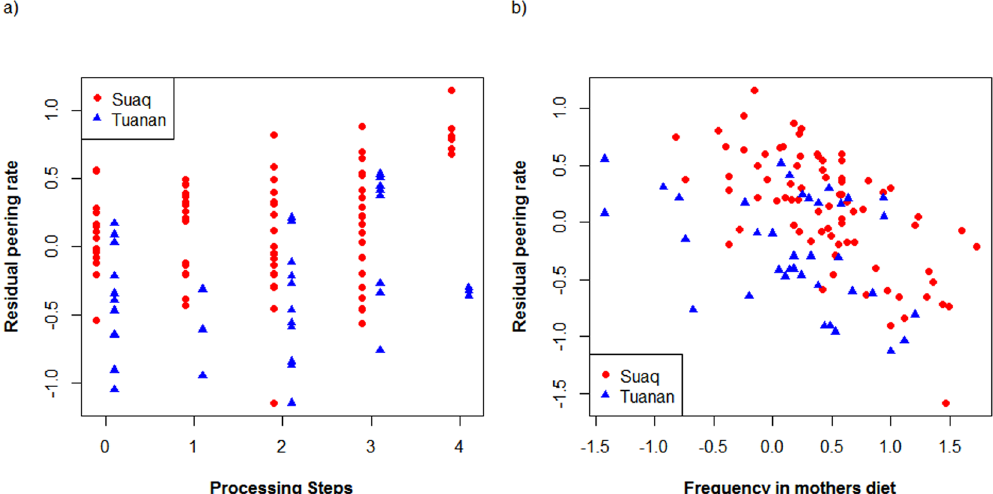
Figure 3. Population differences in immatures’ peering rates in relation to food complexity and frequency: Residual peering rates (corrected for frequency) as a function of complexity ( a ) and residual peering rates (corrected for complexity) as a function of log transformed frequency in the mother’s diet ( b ) for dependent immatures peering at their mothers in the feeding context at Suaq and Tuanan. Residuals were used for illustrative purposes only (see Table 2 for statistics).